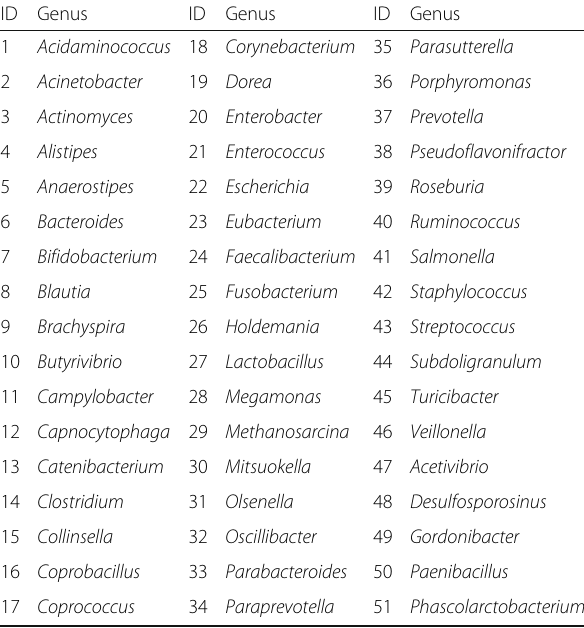
Table 1 List of bacterial genera in the canine and feline global